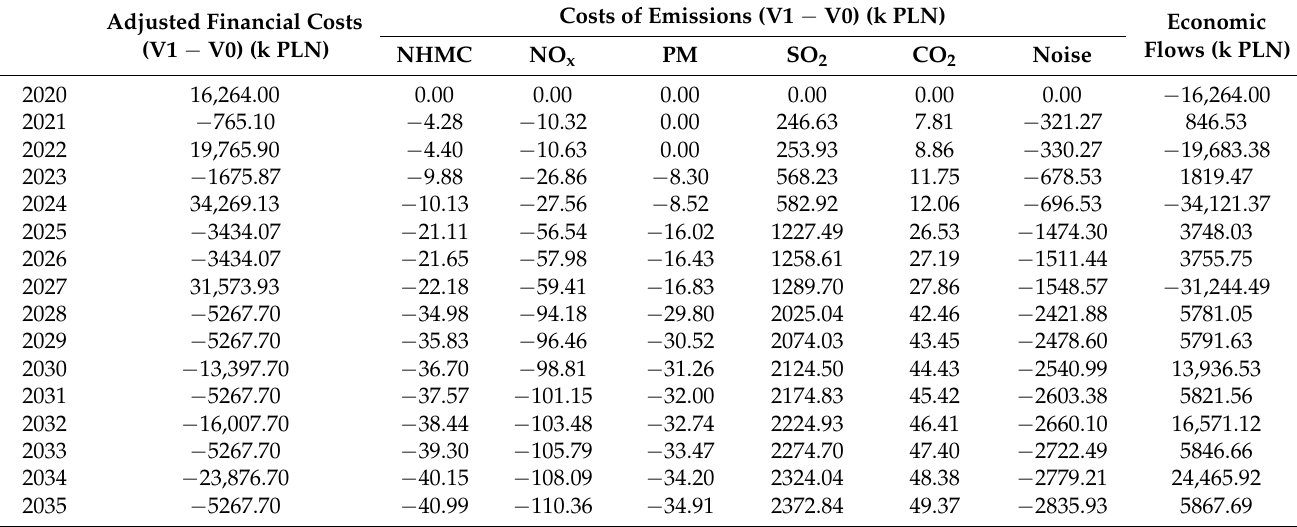
Table 7. Annual economic flows for the years 2020–2035.